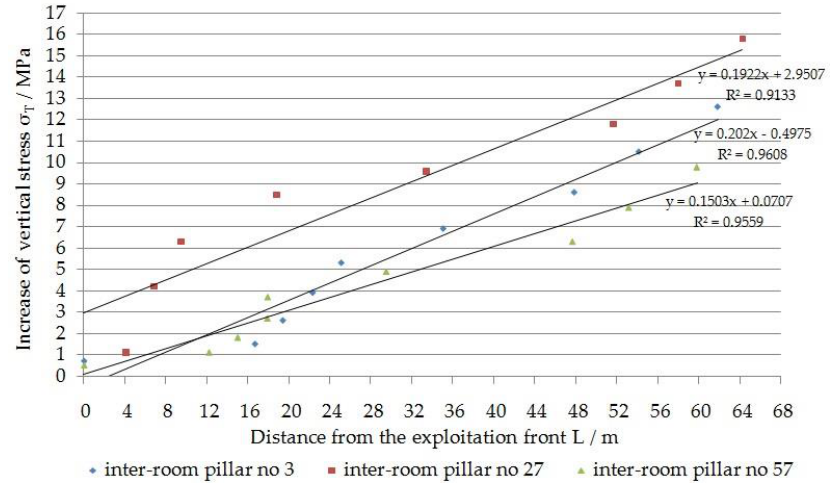
Figure 16. Value of vertical stress increase in inter-chamber pillars.